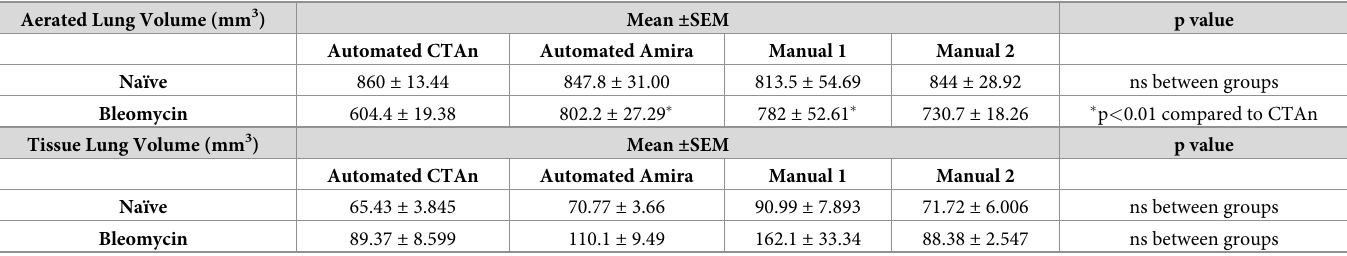
Table 2. Comparison of aerated and lung tissue volume between automated and manual ROI generation. Aerated Lung Volume (mm 3